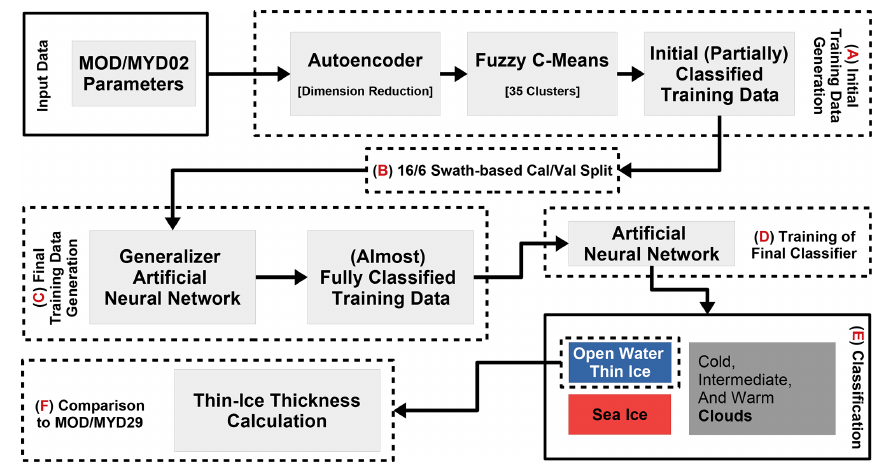
Figure 2. Flow chart summarizing all processing steps from the generation of the initial training data through manual classification of the swath-based split of the data into a calibration and a validation data set (Cal/Val) to the training of the final classifier and its application for open-water–sea-ice–cloud